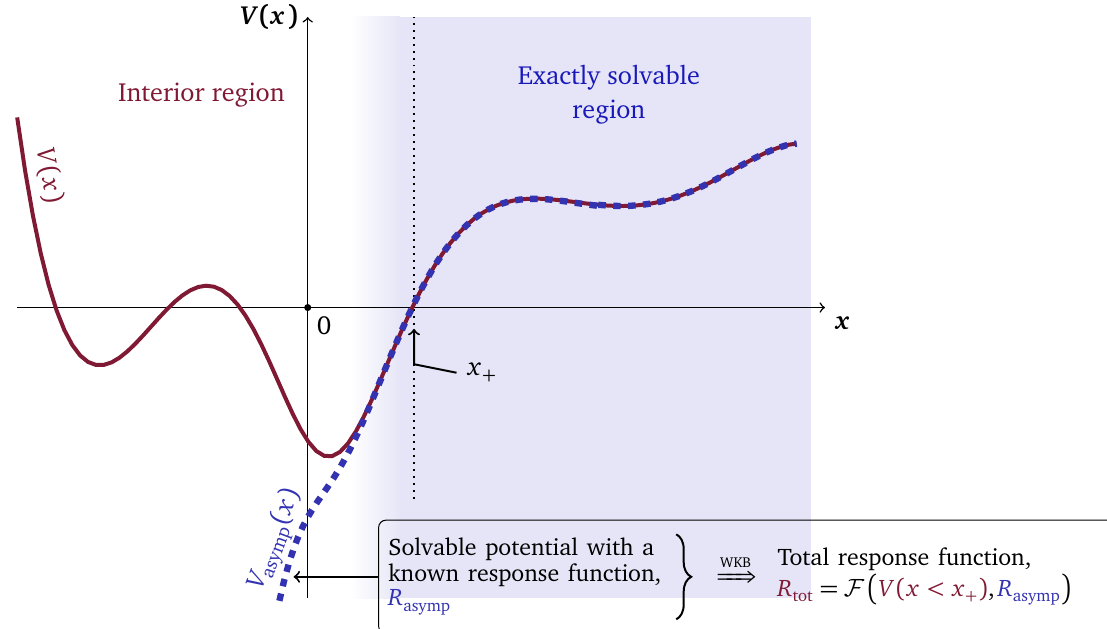
Figure 2: Schematic description of the WKB hybrid technique to derive the response function of a Schrödinger problem given by a potential V ( x ) in red. The response function will be a deformation of the “asymptotic" response function given by the ( x ) with a term which only depends on the po- solvable asymptotic potential V asymp tential in the